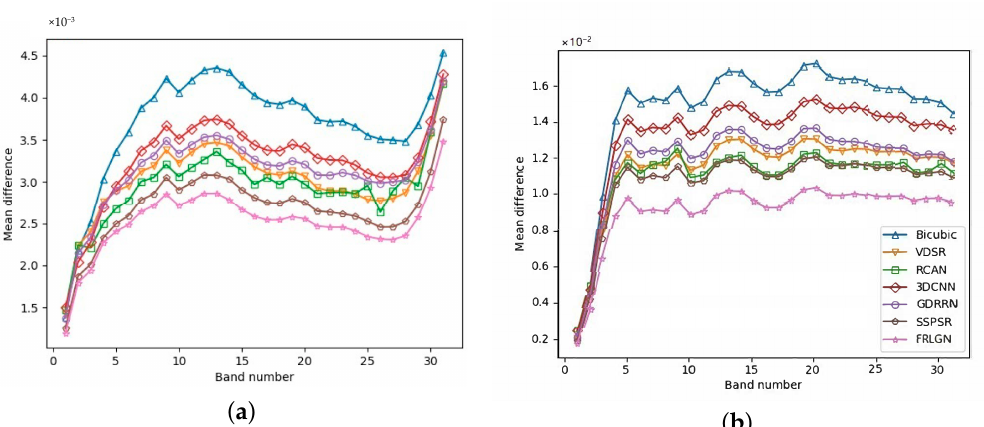
Figure 8. Mean spectral difference curve of two hyperspectral images from the CAVE testing dataset with the scale factor 4: ( a ) sushi, ( b )